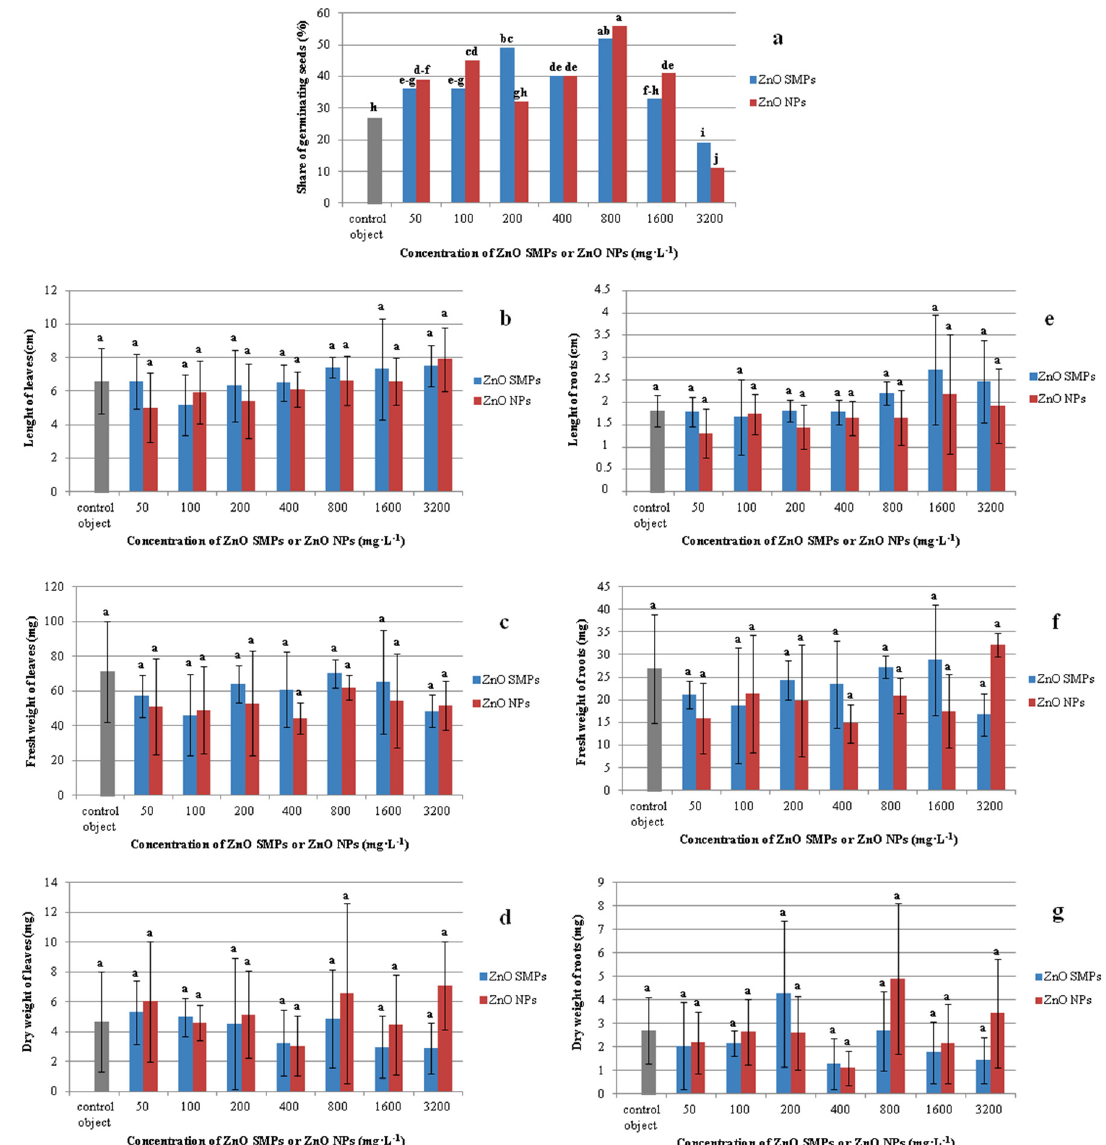
Figure 7. Share of germinating seeds ( a ) and seedling traits ( b – g ) in Allium cepa L. ‘Sochaczewska’ depending on ZnO SMP or ZnO NP treatments. Values represent percentage ( a ) or mean values ± standard deviation ( b – g ), 20 culture jars with five replications (seeds) were included in each treatment. Means on graphs followed by the same letter do not differ significantly at p ≤ 0.05 (Fisher test).